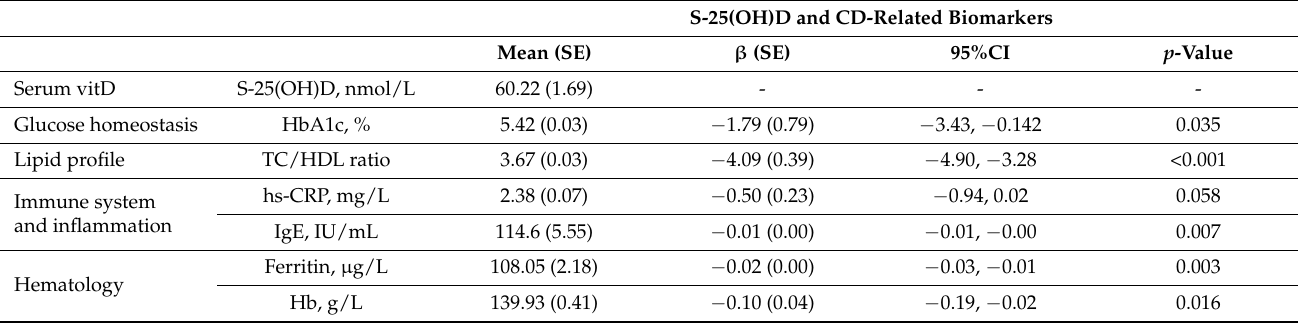
Table A7. Linear regression of S-25(OH)D and chronic-disease-related